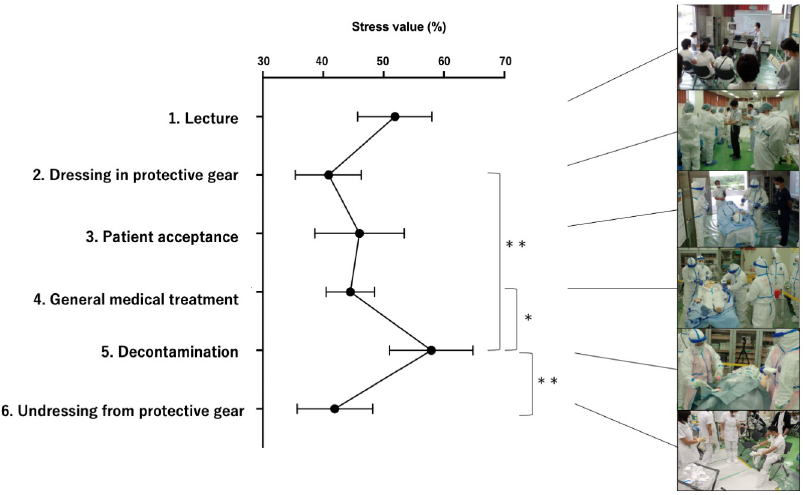
Fig 3. Average stress values of each process. Error bars indicate 95% confidence intervals. � ; P < 0.05, �� ; P < 0.01.